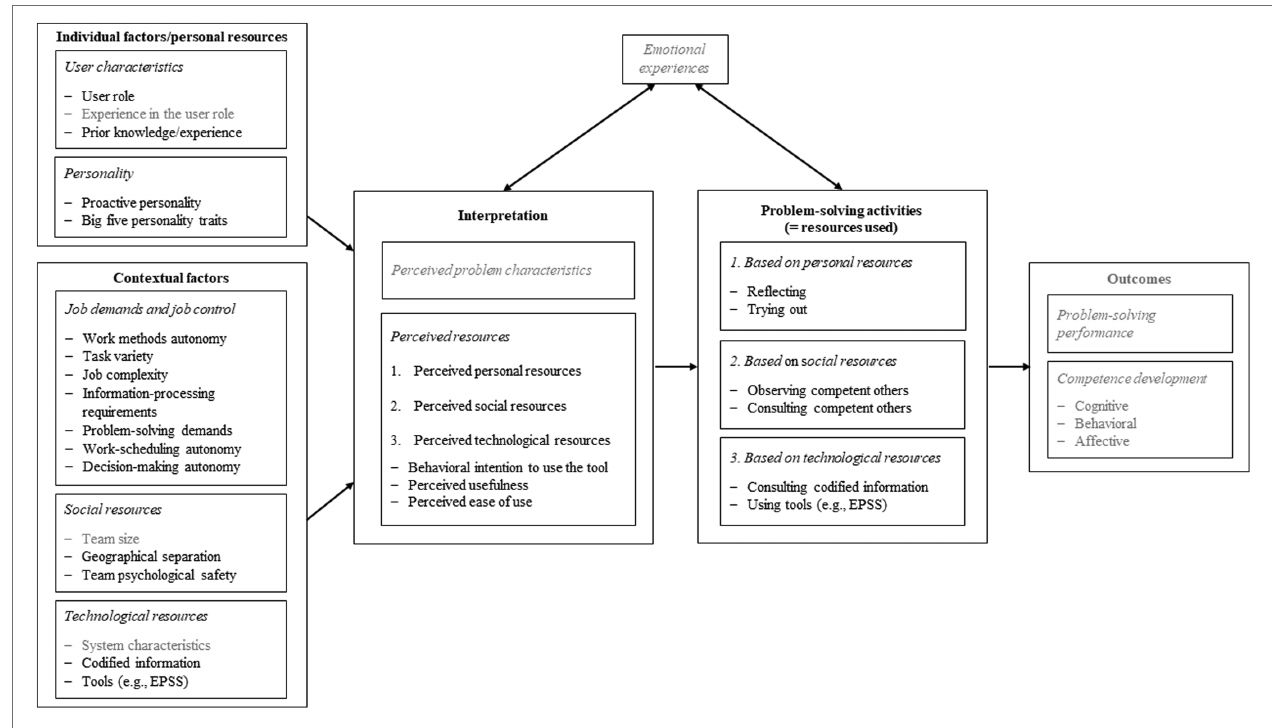
FIGURE 2 | Model of informal workplace learning through